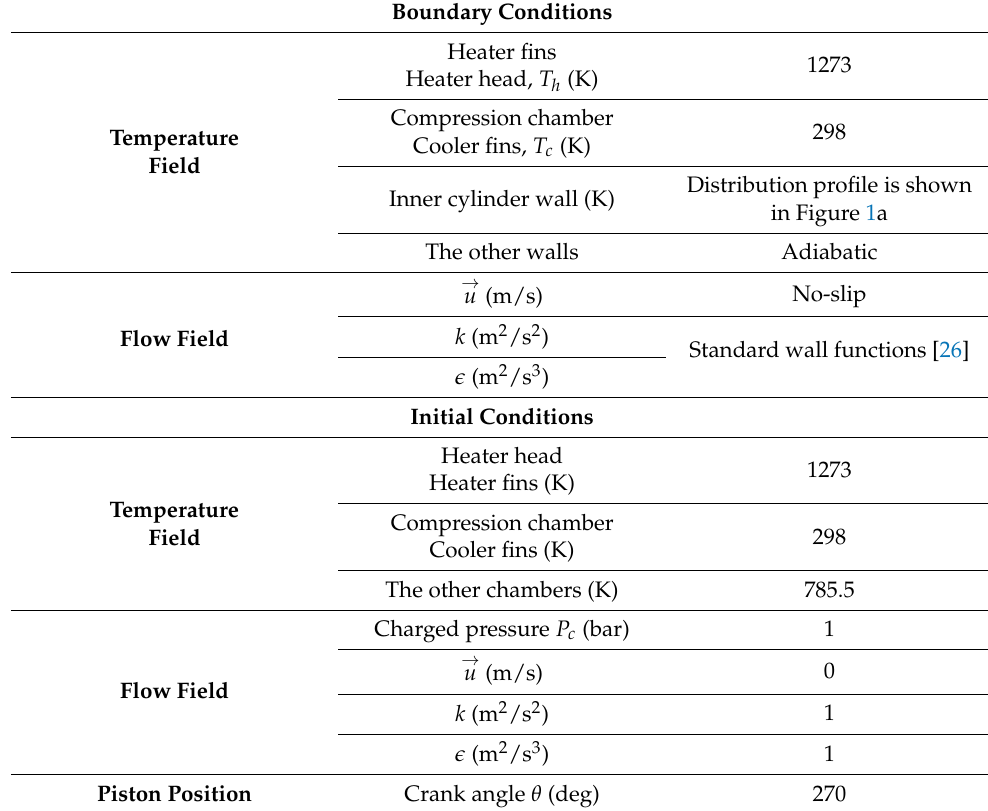
Table 2. Boundary and initial conditions of the baseline case.